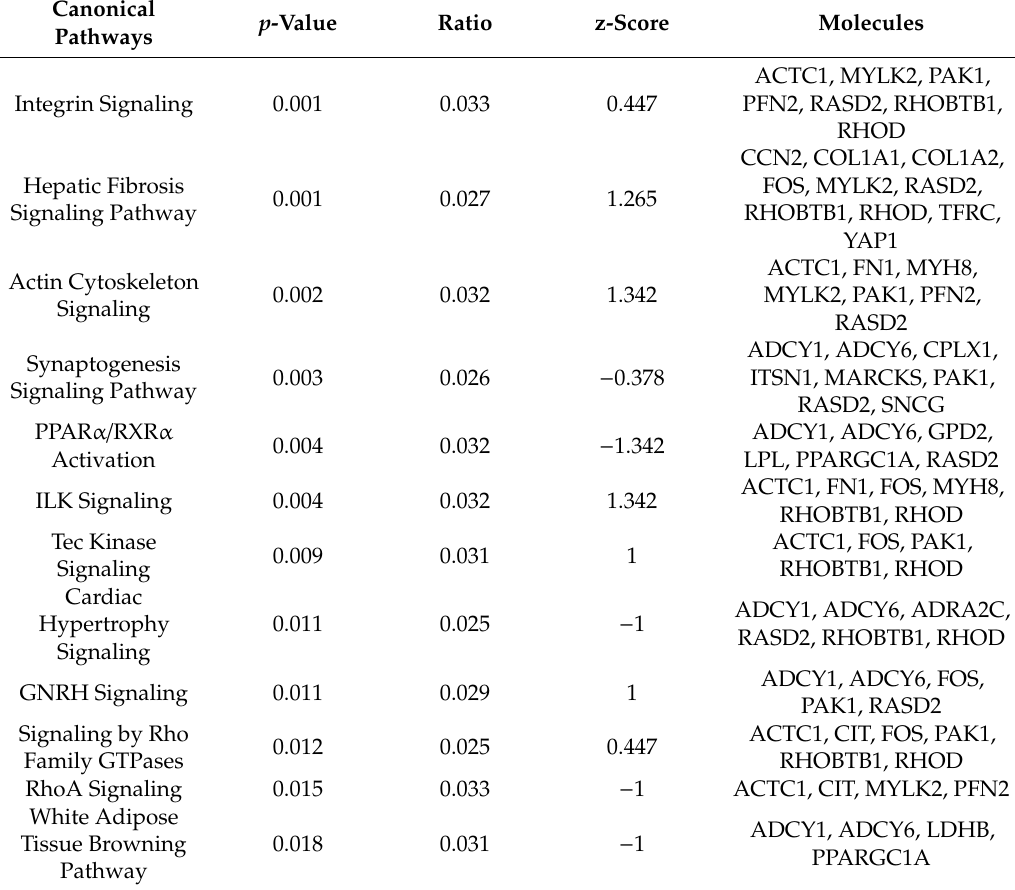
Table 4. List of significant pathways ( p -value < 0.05) with assigned z-score identified in the set of DEGs according to the Tender and Tough group identified by Ingenuity Pathway Analysis (IPA)